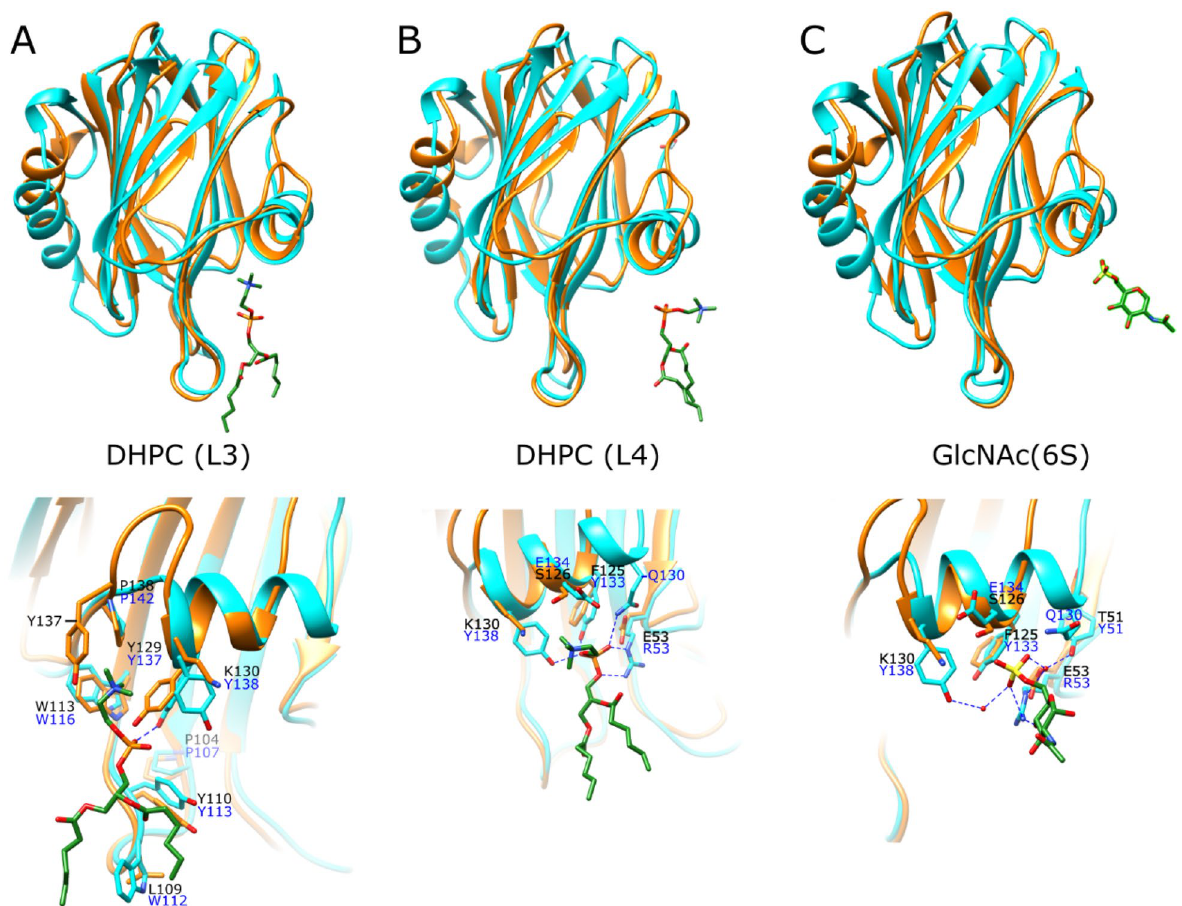
Figure 7. Structural comparison of actinoporin lipid-binding. Superimpose of HALT-1 (orange) with ( A ) AfFraC protein bound with DHPC ligand in L3 position (blue, PDB ID: 4TSO), ( B ) AfFraC protein bound with DHPC ligand in L4 position (blue, PDB:4TSQ), and ( C ) AfFraC protein bound with GlcNAc(6S) (blue, PDB ID:5GWF) are shown. Zoom in view of each binding sites are shown. Putative hydrogen bonds are shown as blue dashed lines. Ligands are depicted as sticks with the carbon, phosphate, nitrogen, and oxygen atoms as green, orange, blue, and red, respectively. Residues for HALT-1 and AfFraC protein are labelled in black and blue, respectively. The figures were generated using the program Chimera 34